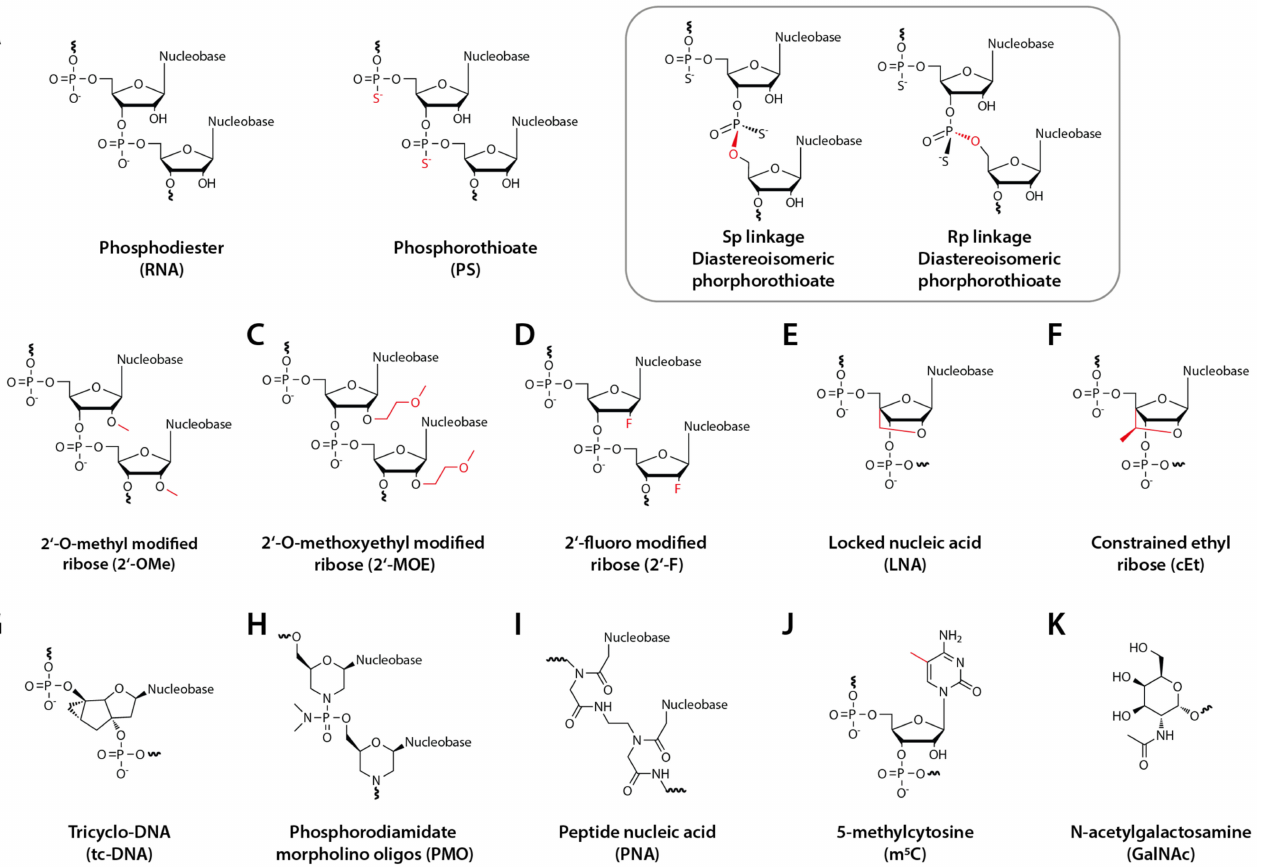
Figure 1. Structures of AON chemical modifications and the GalNAc conjugate. ( A ) Phosphodiester and Phospho- rothioate (PS), inset: Rp and Sp diastereoisomers, ( B ) 2 (cid:48) -O-methyl modified ribose (2 (cid:48) -OMe), ( C ) 2 (cid:48) -O-methoxyethyl modified ribose (2 (cid:48) -MOE) ( D ) 2 (cid:48) fluoro (2 (cid:48) -F), ( E ) Locked nucleic acid (LNA) ( F ) Constrained ethyl (cEt), ( G ) Tricyclo-DNA (tcDNA), ( H ) Phosphorodiamidate morpholino oligos (PMO), ( I ) Peptide nucleic acid (PNA), ( J ) 5-methyl-cytosine (m 5 C), and ( K ) N-acetylgalactosamine